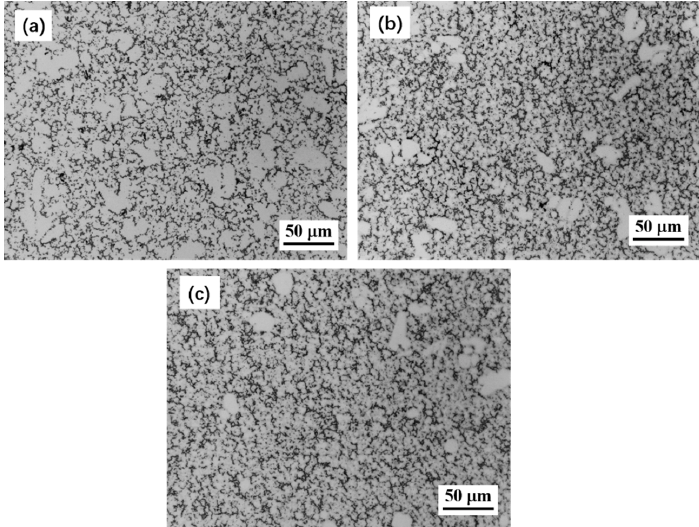
Figure 4. Optical micrographs of the as-cast Mg-6Zn-4Al- x Sn alloys: ( a ) ZA64, ( b ) ZAT641, and ( c ) ZAT642.